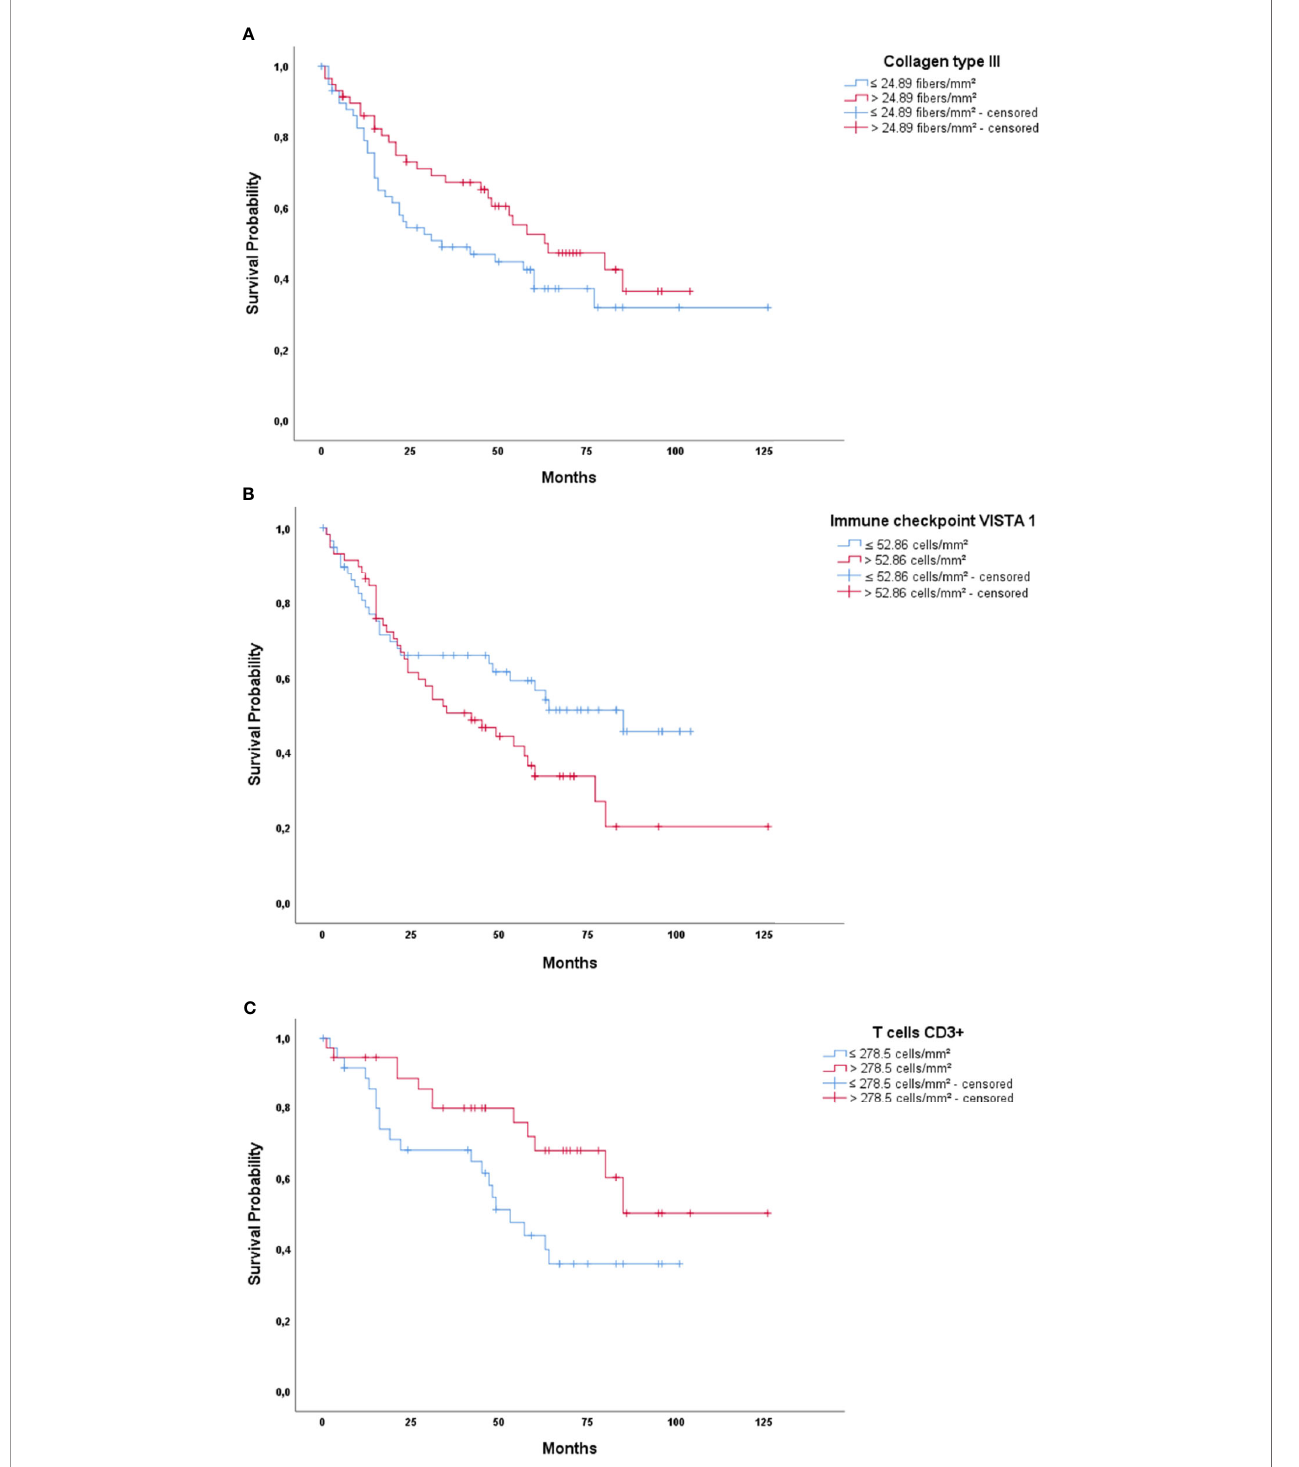
FIGURE 7 | Kaplan-Meier plots of survival probability versus follow-up time in months in those patients with pathological early (A) and advanced stage disease (B, C) . (A) Col III in early disease patients showing better survival for patients with high Col III expression. (B) Immune checkpoint VISTA 1 in advanced stage patients, showing better survival for patients with low VISTA 1 expression. (C) T cells CD3+ in advanced stage patients, showing better survival time for patients with high CD3+